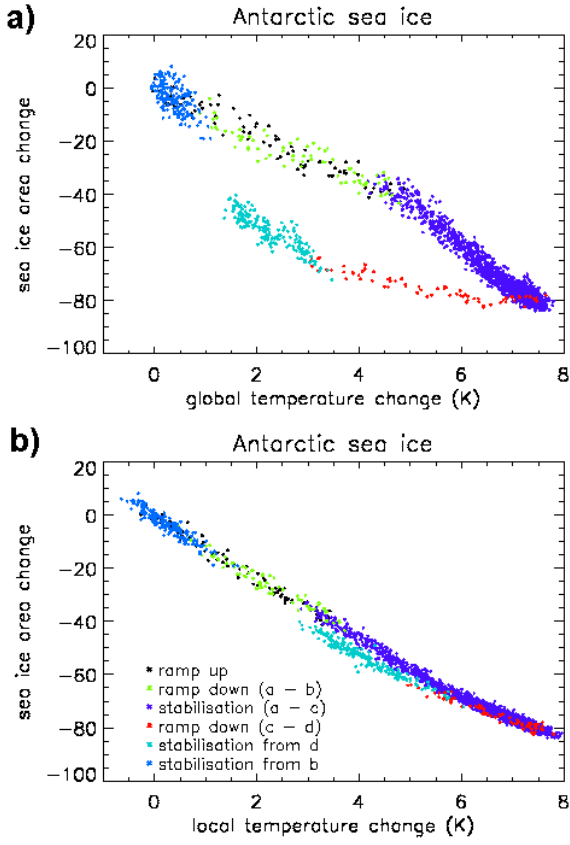
Fig. 3. The sensitivity of Antarctic sea ice area change to (a) global Figure 3. The sensitivity of Antarctic sea ice area change to a) global temperature temperature change and (b) local temperature change. Colours refer to the CO 2 trajectory markers specified in Fig. change and b) local temperature change. Colours refer to the CO2 trajectory markers specified in figure 1